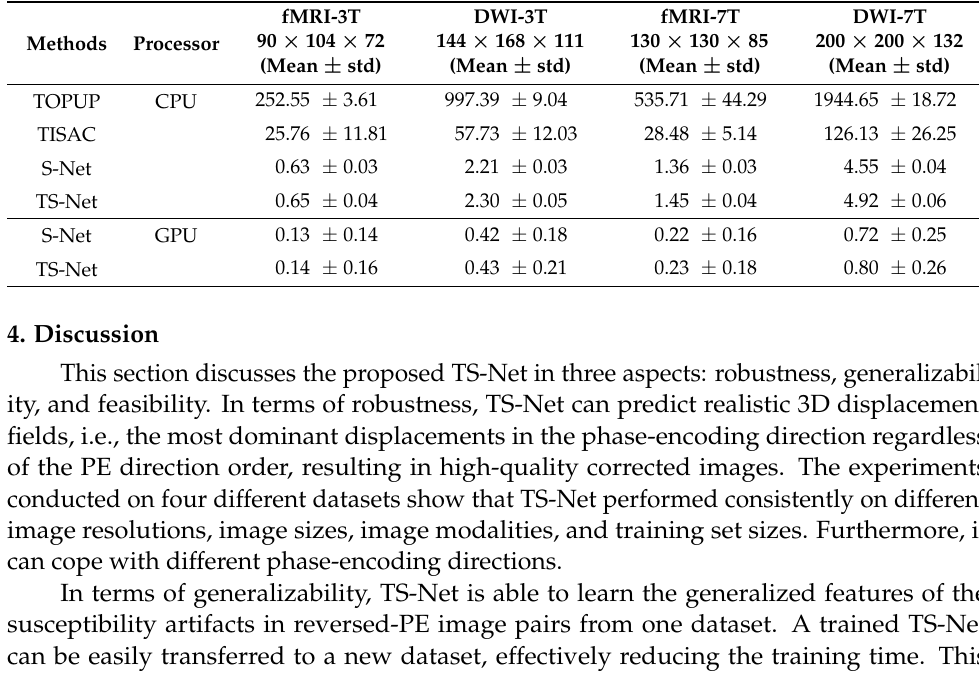
Figure 7. Comparisons of the proposed TS-Net versus other three SAC methods in terms of the LNCC-based accuracy on the test sets. Due to differences in the LNCC ranges of the datasets, the plots are drawn in different y -axis ranges for clarity. In each box plot, the top line is the maximum LNCC value excluding the outliers; the bottom line is the minimum LNCC value excluding the outliers; the middle line is the median LNCC value; the solid rectangle is the interquartile range of the LNCC values; the points are the outliers. Table 5. Processing time (in seconds) of SAC methods for correcting a pair of reversed-PE